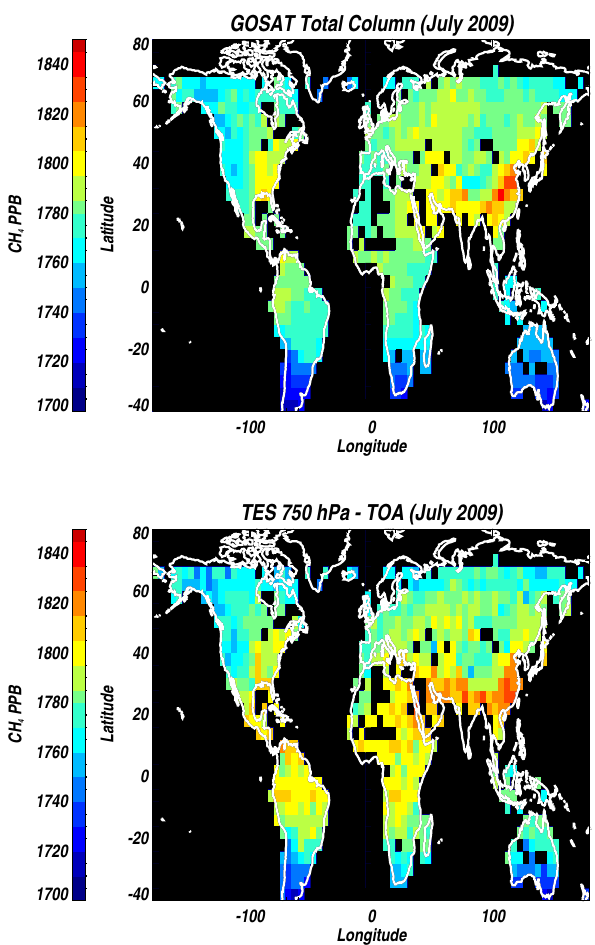
Figure 2. Top: XCH 4 from the GOSAT instrument. Black indicates no data. Bottom: XCH 4 from the Aura TES instrument for the free troposphere to stratosphere (typically 750hPa to TOA). Black indi- cates no